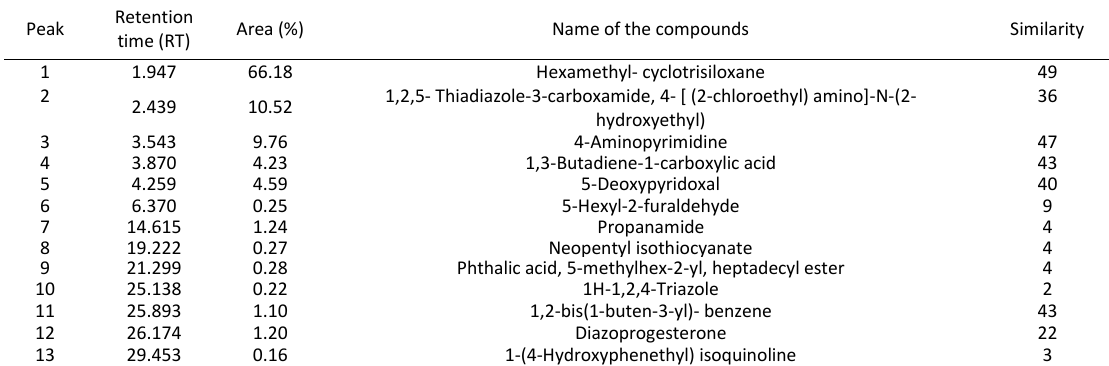
Table 5: GC-MS analysis of K. alvarezii ethanolic extract